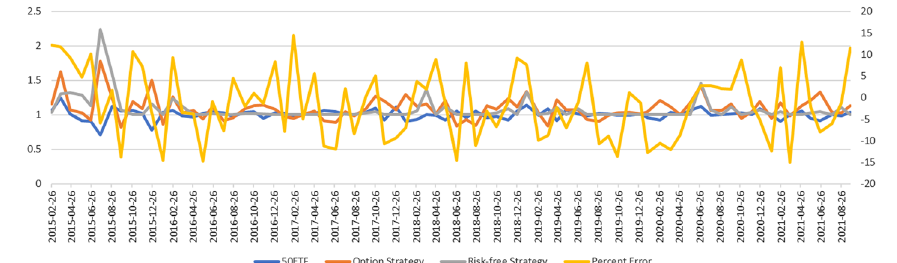
Fig. 6 Out-of-sample monthly return of different model and prediction error. Note : This figure shows the monthly yield of the underlying asset 50ETF, intelligent option model and risk-free model from 2015 to 2021. The yellow line indicates the prediction error. The ordinate on the left is the average monthly rate of return, and the ordinate on the right is the prediction